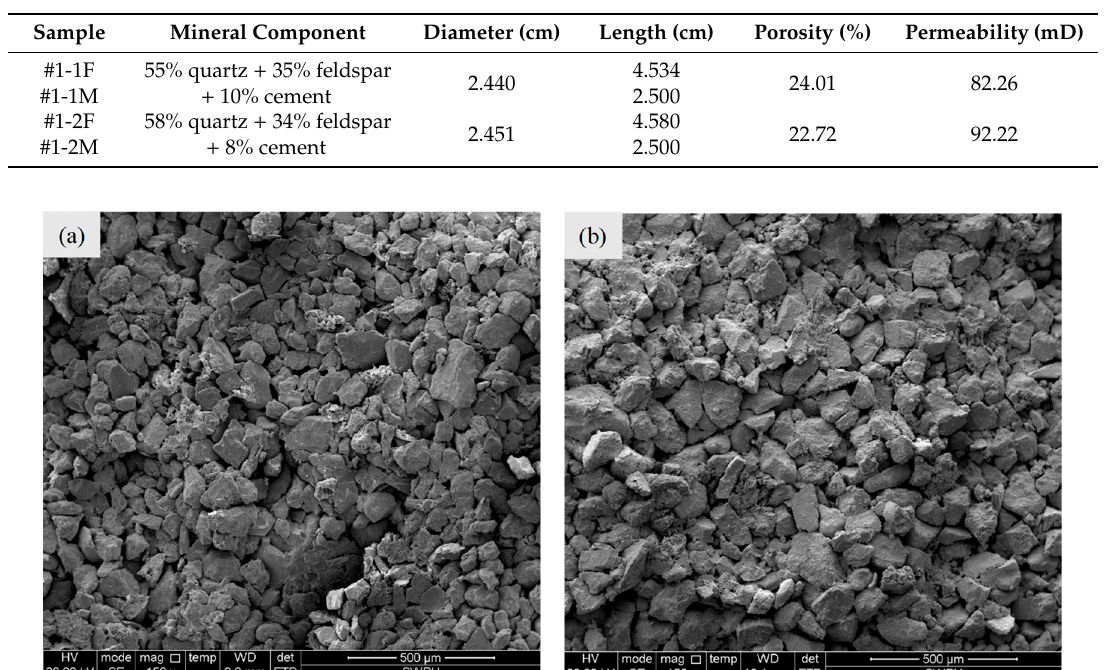
Figure 1. The scanning electron microscopy photos of samples: ( a ) #1-1; ( b ) #1-2.